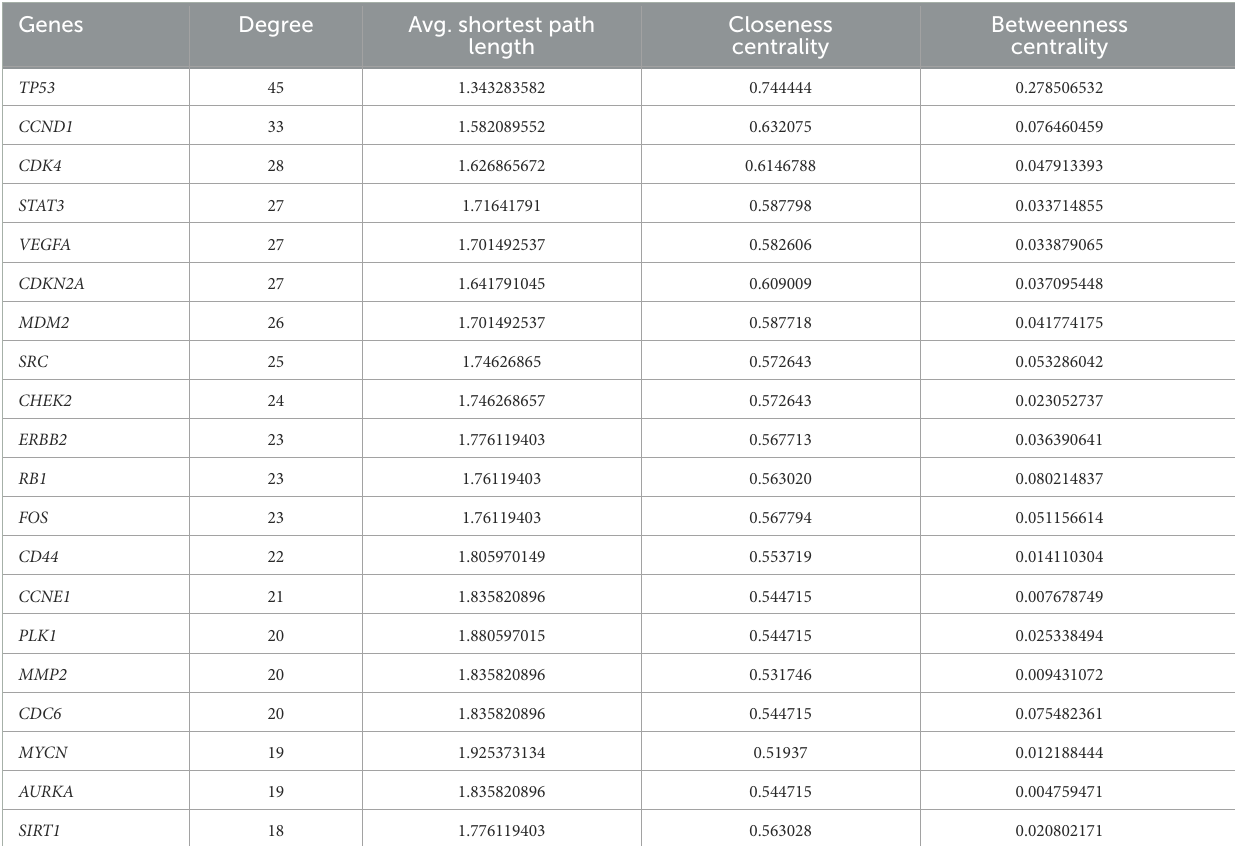
TABLE 1 The list of the top 20 genes in Osteosarcoma analyzed by NetworkAnalyzer. Genes Degree Avg. shortest path